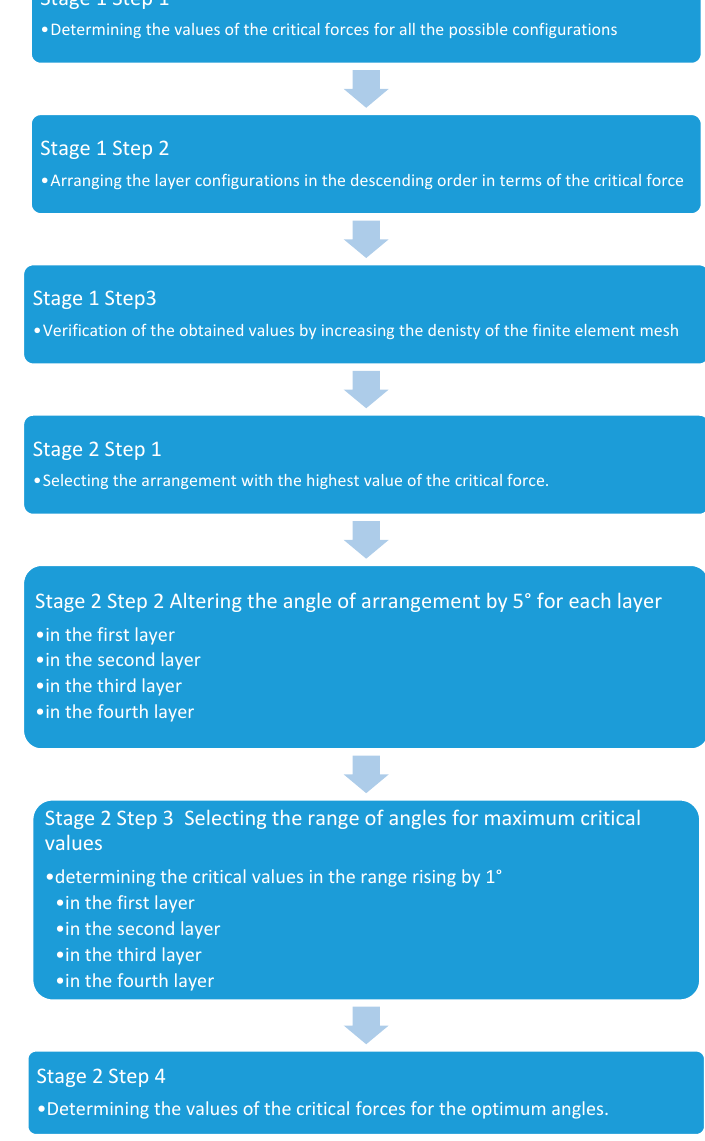
Figure 3. An algorithm for the determination of layer configuration for the highest critical force.